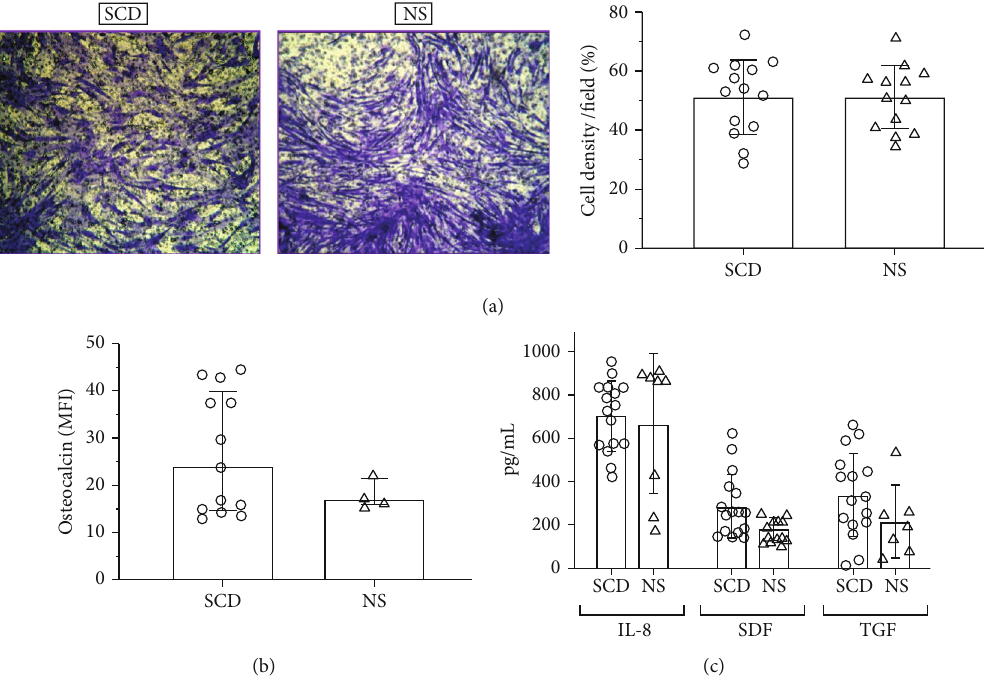
Figure 5: BM-MSCs from SCD and NS patients showed no signi fi cant di ff erences in migration, osteogenic marker, and secreted cytokines. (a) Boyden chamber analysis. Uncoated Boyden chambers were used to analyze migration of BM-MSCs. Cells that migrated through the chambers were stained with crystal violet and quantitated (right). (b) Quanti fi cation of intracellular osteocalcin expression in BM-MSCs grown under osteoinductive conditions for 10 days. (c) Enzyme-linked immunosorbent assay for interleukin-8 (IL-8), stromal cell-derived factor-1 alpha (SDF-1 α ), and transforming growth factor-beta (TGF- β ). Concentration (pg/mL) of cytokines and growth factors in supernatants of BM-MSCs. Statistical analyses (Mann – Whitney U test) were performed between values, and the data are reported as the median and interquartile